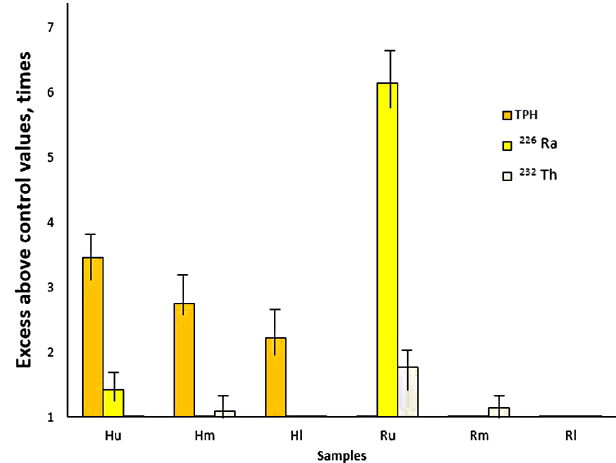
Figure 1. FExcess TPH content and activity concentrations of ra- dionuclides in soil sampled from H -columns (contaminated by the raw waste containing oily compounds and radionuclides) and R - columns (contaminated by treated waste containing mainly radionu- clides) in different layers [upper (0–20cm; u ), middle (20–40cm; m ), and lower (40–60cm; l )] above the corresponding values of the control